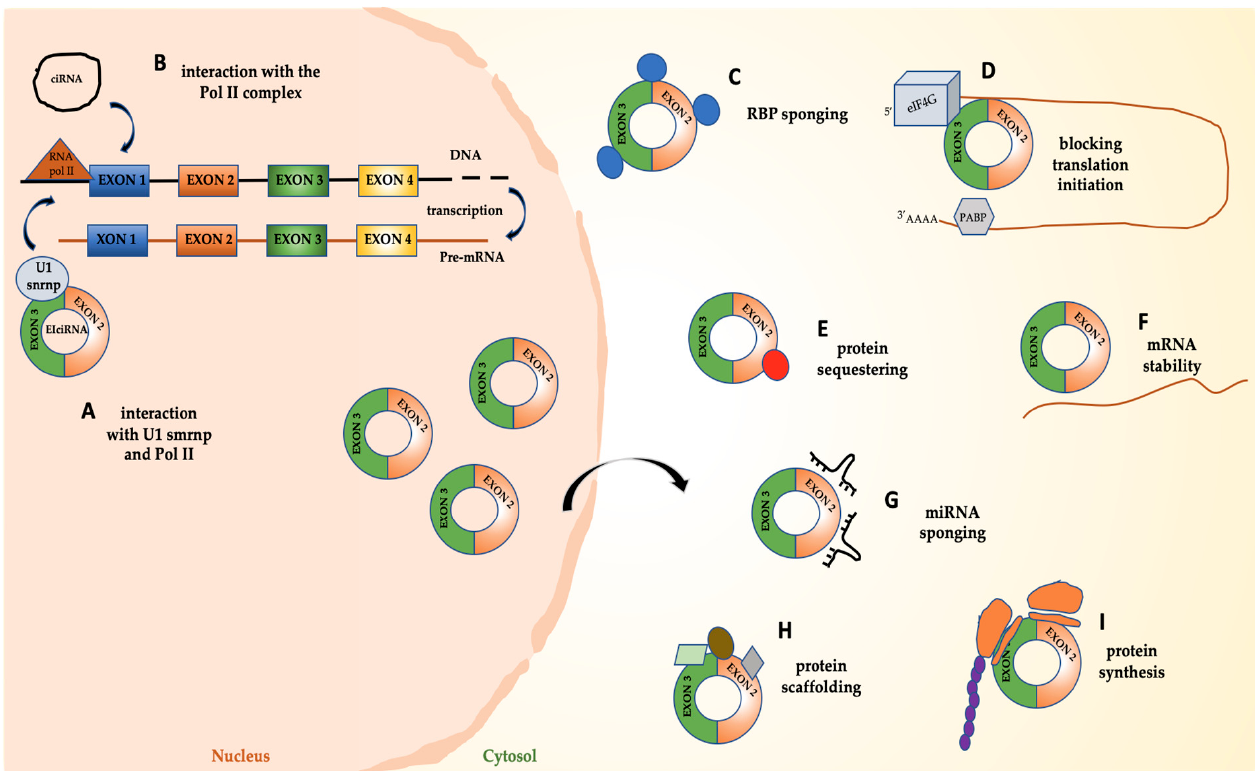
Figure 2. Functional mechanisms of circRNAs. EIciNAs can form a complex with U1 small nuclear ribonucleoprotein (U1 snRNP) and bind RNA PolII to enhance transcription ( A ). CiRNAs can interact with RNA PolII to positively modulate transcription ( B ). CircRNAs can act as sponges of RBPs, thus impacting their pleiotropic functions ( C ); they can control translation initiation ( D ), protein sequestering, localization or function ( E ). Moreover, circRNAs can affect mRNA stability ( F ); sponge miRNAs, thus interfering with the post-transcriptional regulation of their target mRNAs ( G ), or act as scaffold for proteins ( H ). Some circRNAs can also be translated ( I